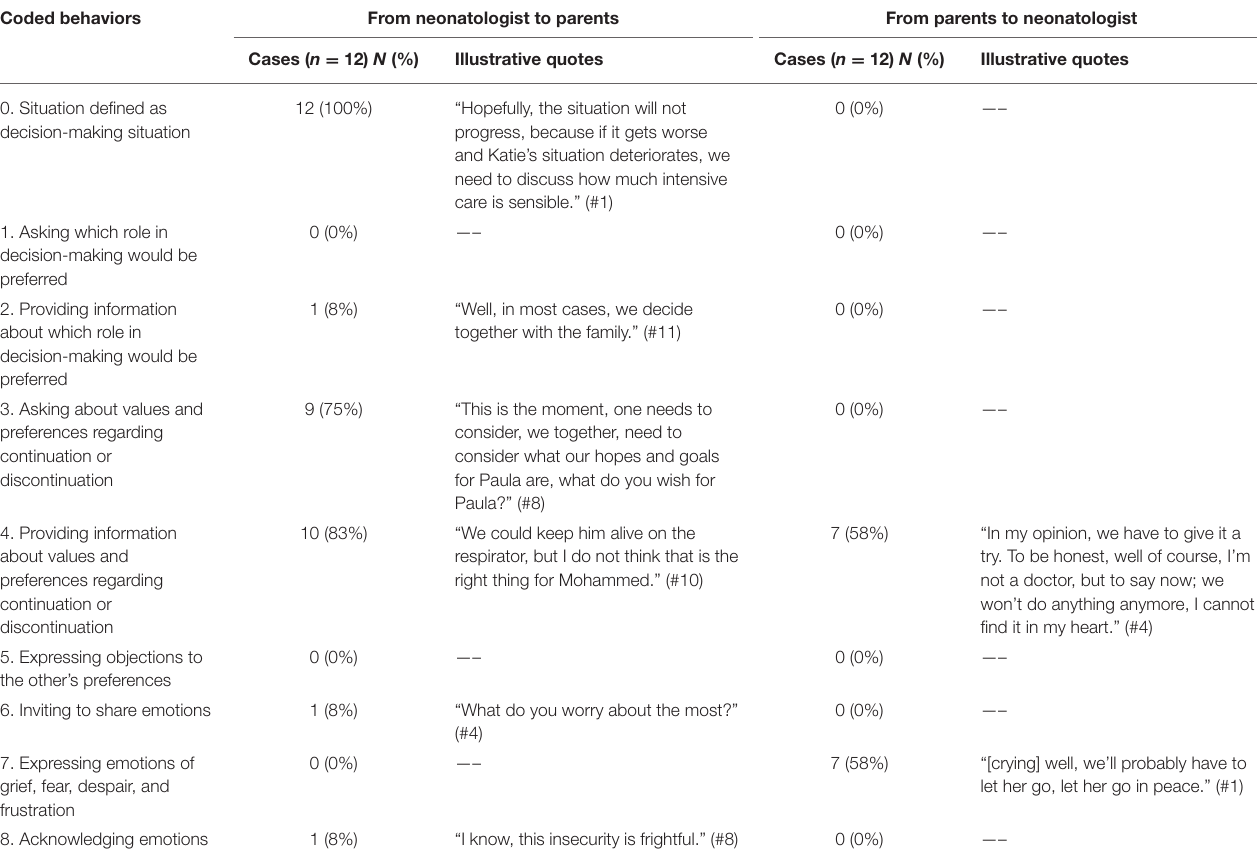
TABLE 4 | Stage 2: